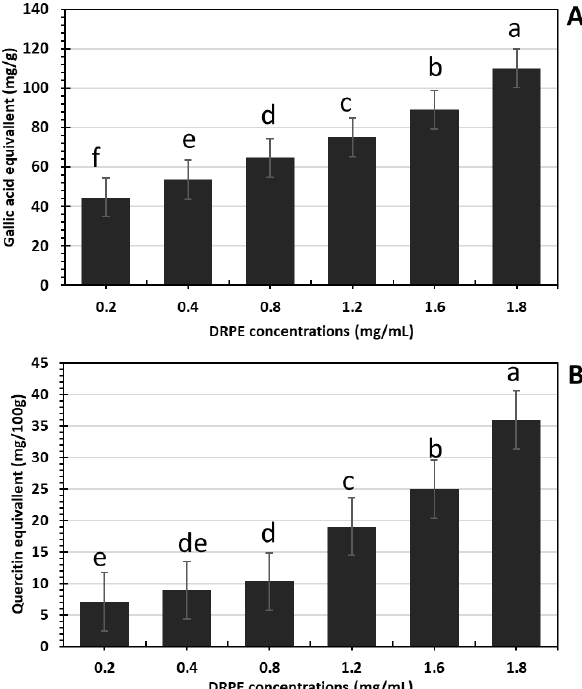
Figure 8. ( A ) Scavenging activity of DRPE concentrations against DPPH free radicals; ( B ) ferric- reducing power of DRPE concentrations. Lowercase letters above the columns indicate significant differences at a 5% probability level.